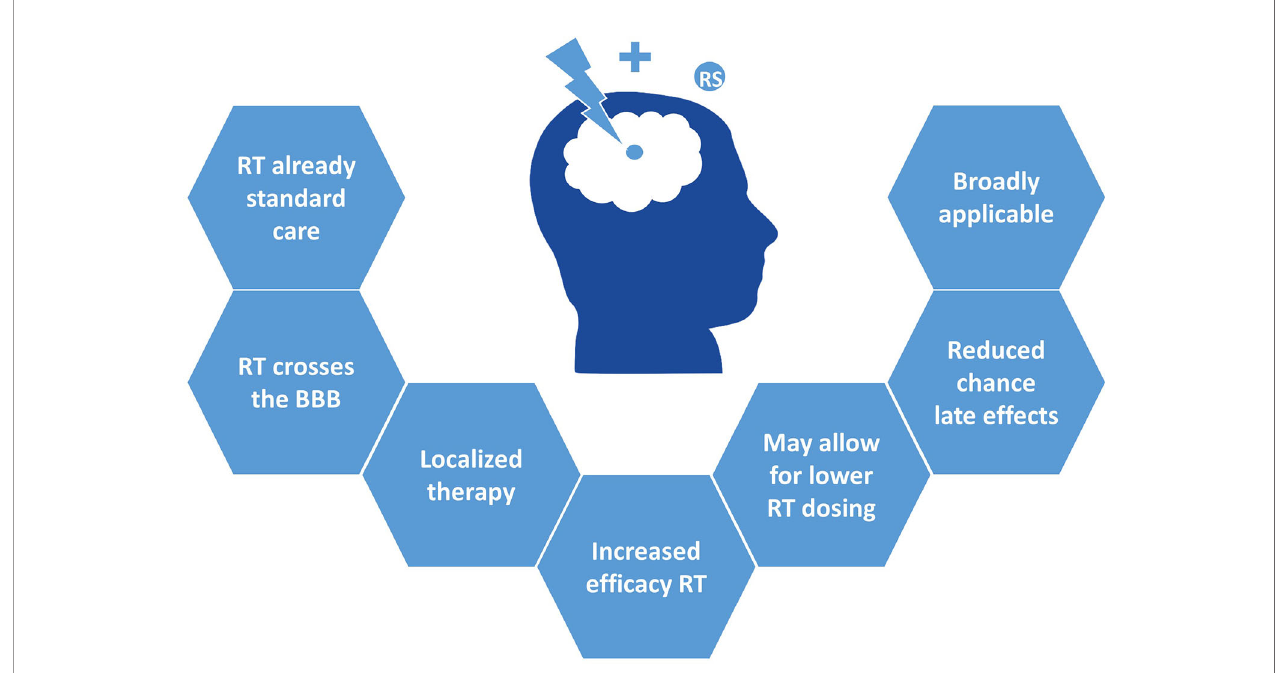
FIGURE 1 | Clinical advantages of radiosensitizers in